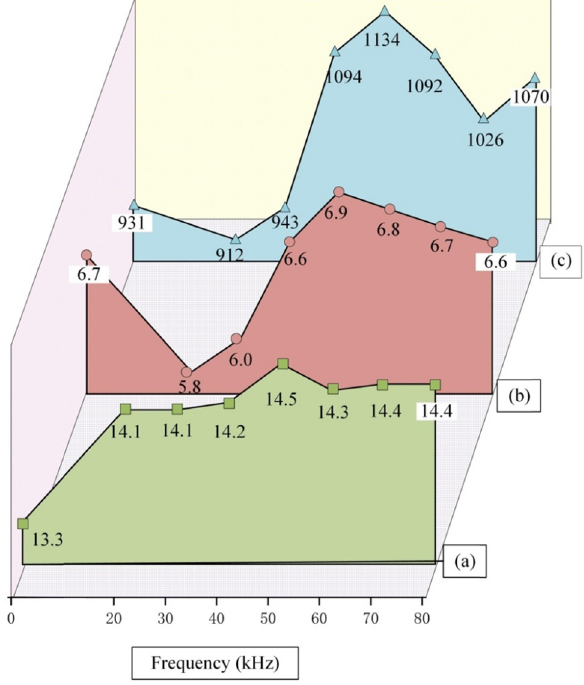
Figure 8: Arc characteristics versus frequencies: ( a ) arc diameter, ( b ) arc length, and ( c ) arc